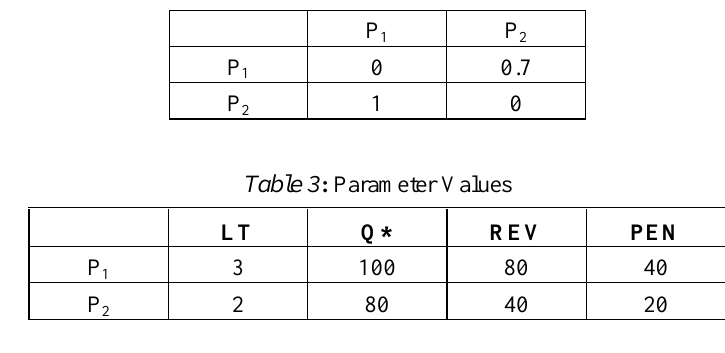
Table 2 : Dependency Factor Matrix Based on Historical Data